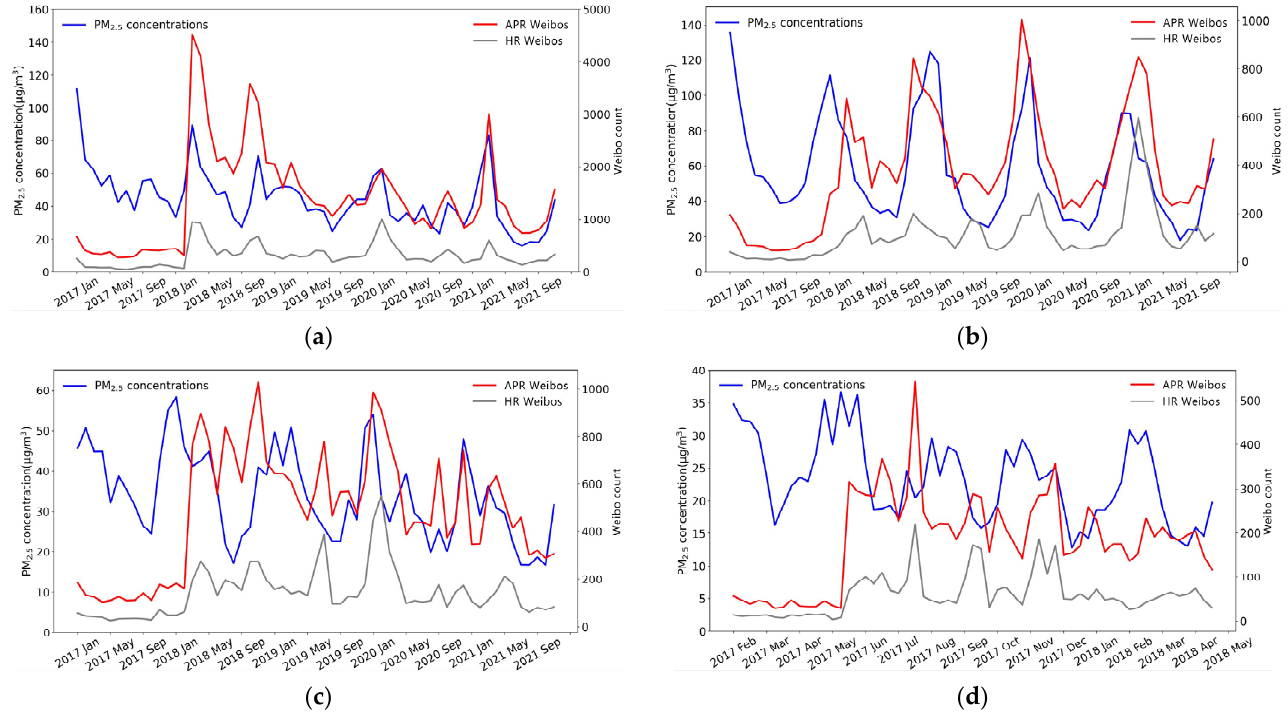
Figure 8. Trends of monthly APR Weibos, monthly HR Weibos, and monthly average PM 2.5 concen- tration in 2017–2021: ( a ) Beijing; ( b ) Henan; ( c ) Shanghai; ( d ) Fujian. tration in 2017–2021: ( a ) Beijing; ( b ) Henan; ( c ) Shanghai; ( d )